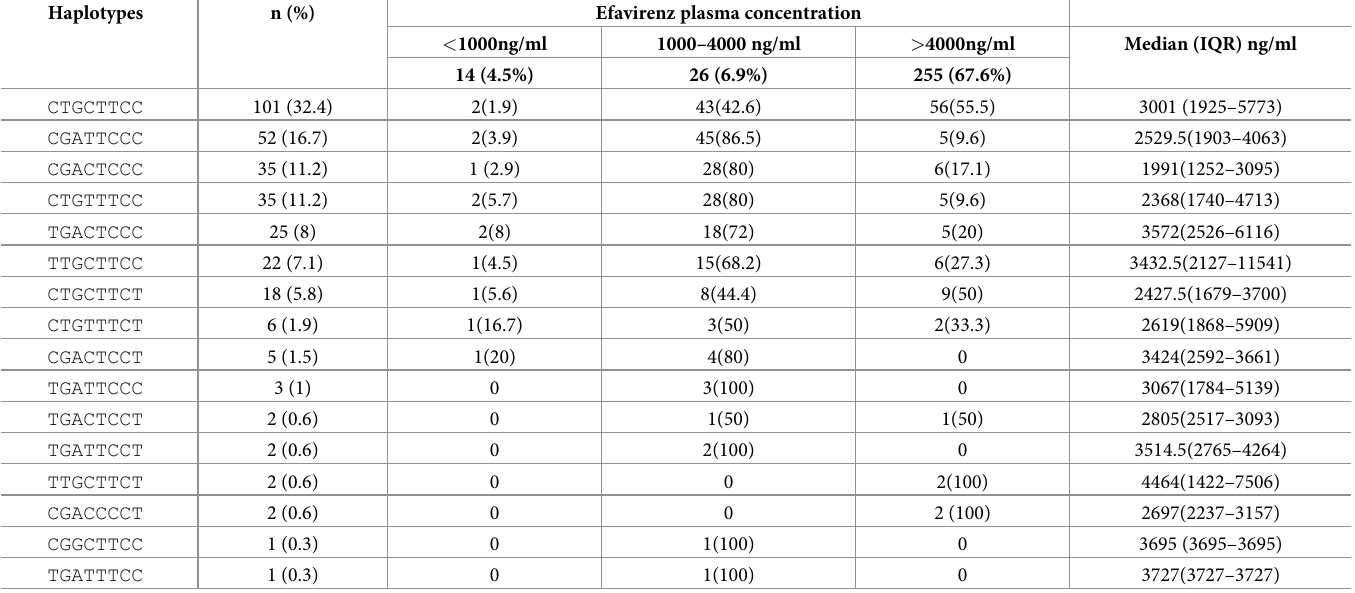
Table 4. Relationship between haplotypes and EFV plasma concentrations.